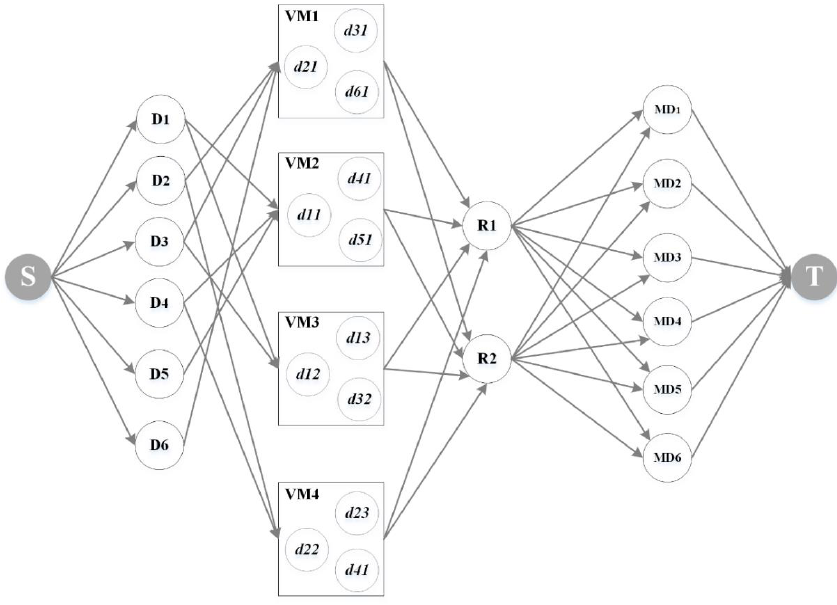
Figure 8. Maximum flow scheduling model of experimental spatiotemporal data.